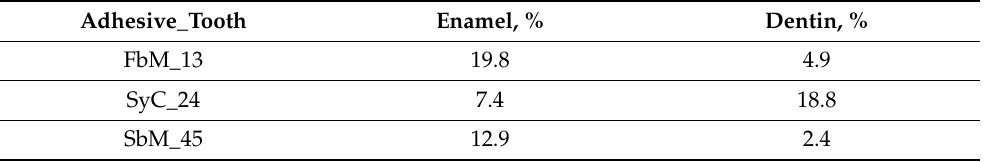
Table 1. Mean fractions (%) of interfacial adhesive defect length at enamel and dentin of the samples, determined as described in the Materials and Methods Section